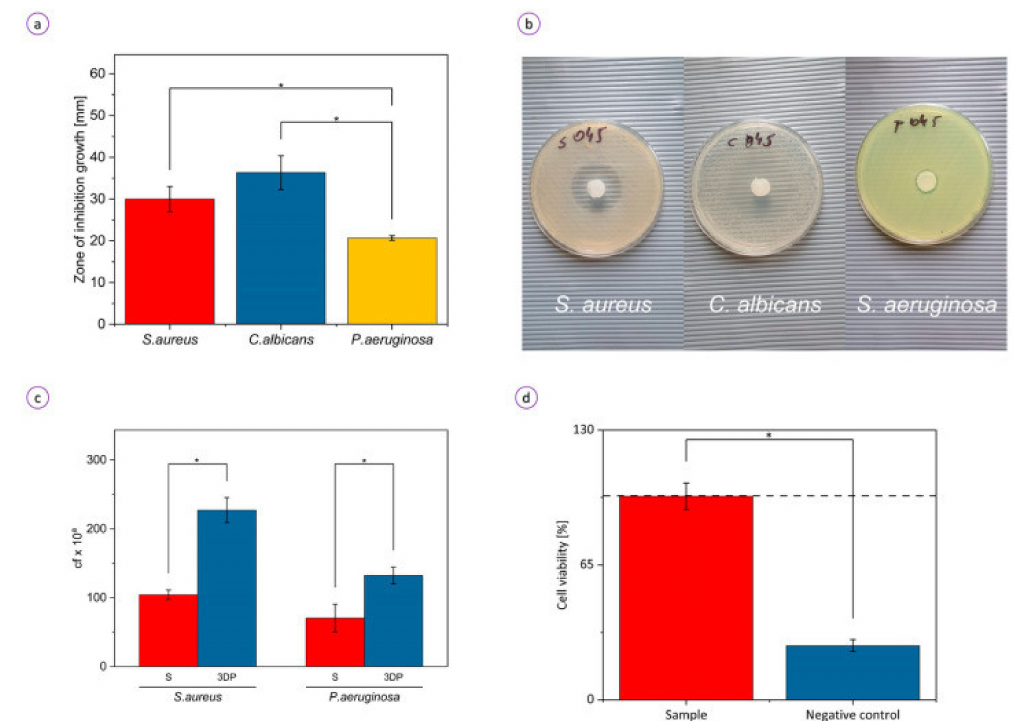
Figure 8. Biological activity of the hydrogel: ( a ) mediocre diameter of hindrance regions of S. aureus, C. albicans , and P. aeruginosa and ( b ) corresponding photos of the dishes; ( c ) ability of S. aureus and P. aeruginosa to colonize the molded (S) and 3D-printed (3DP) hydrogel samples. An exponent “a” corresponds to 9 and 6 for S. aureus and P. aeruginosa , respectively; “cf” means colony-forming; ( d ) viability of fibroblasts exposed to medium conditioned with elicits from the analyzed sample and ethanol (negative control). * p < 0.05. Copyright 2021 MDPI. Reprinted with permission from ref.